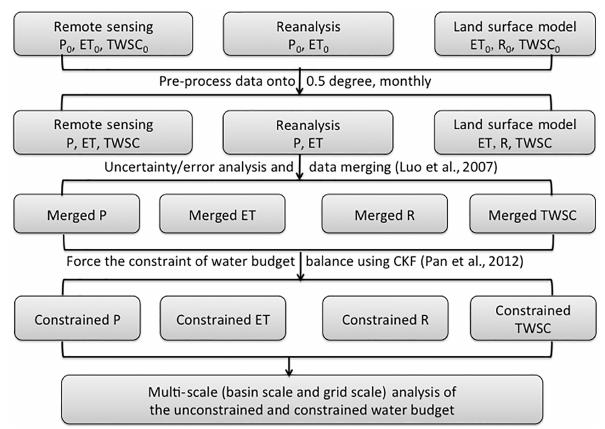
Figure 11. The flowchart describes the progress of data preprocess- ing, error analysis, water balance constraint, and multi-scale water budget